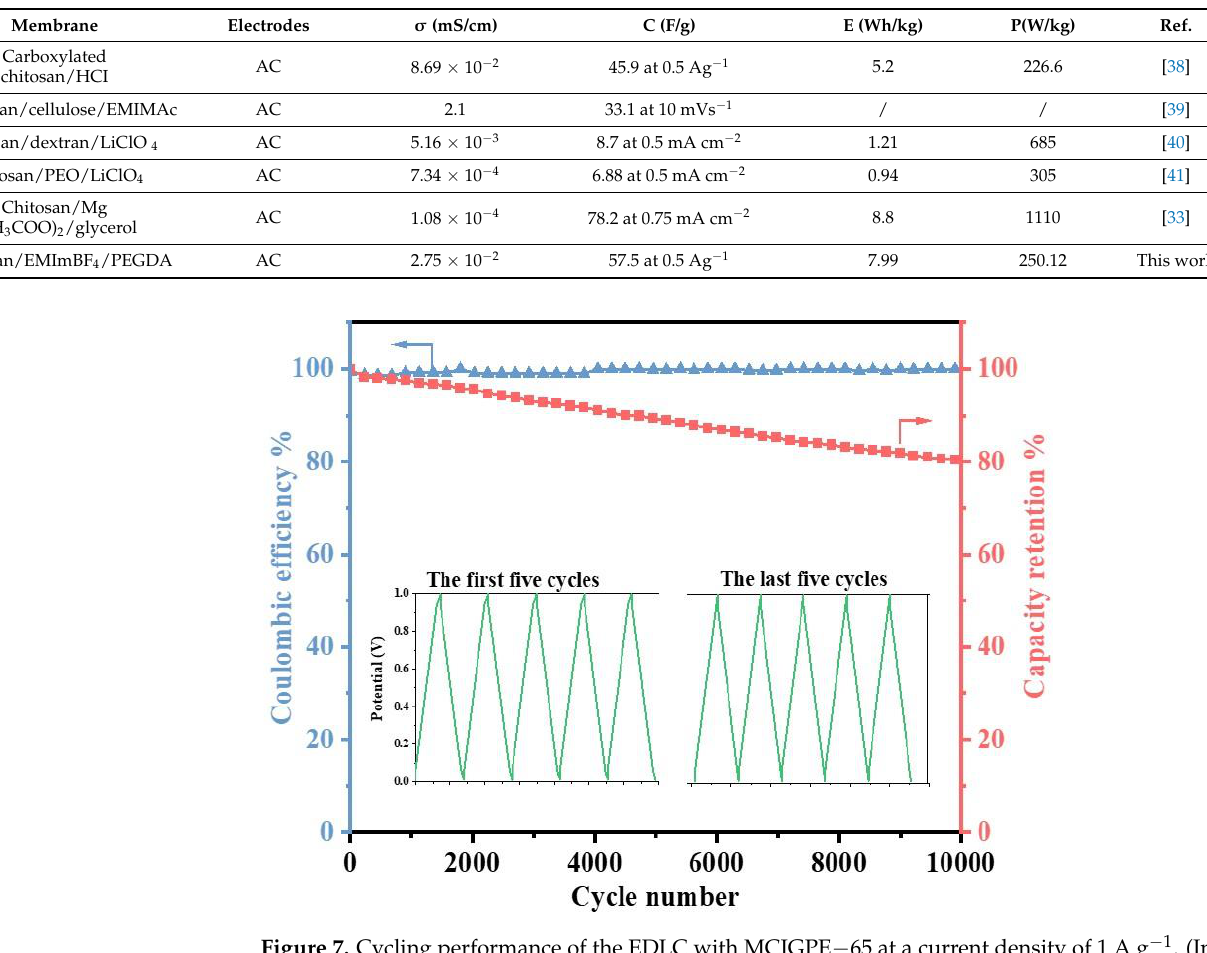
Figure 7. Cycling performance of the EDLC with MCIGPE−65 at a current density of 1 A g −1 . (Inset: GCD curve of the first five cycles and last five cycles).